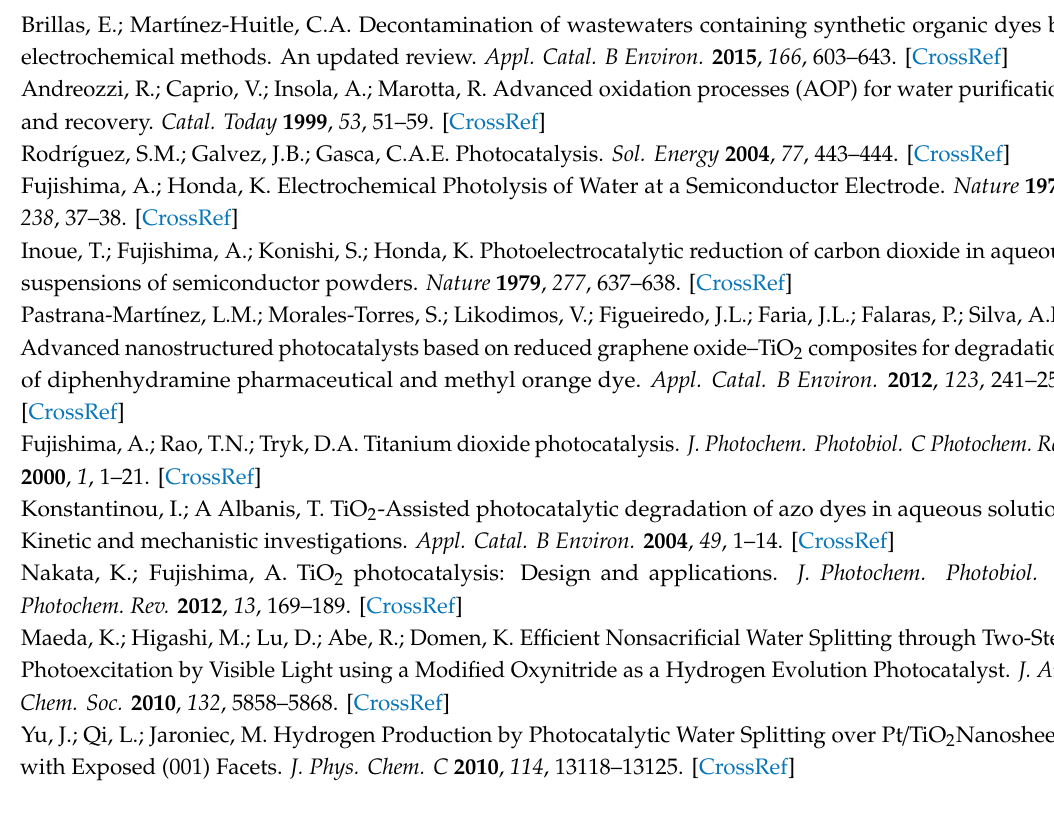
Figure S1: Normalized concentration of OG as a function of time pH values of 3.0, 6.0 (natural pH), and 10.0 for (a) GO-T and (b)